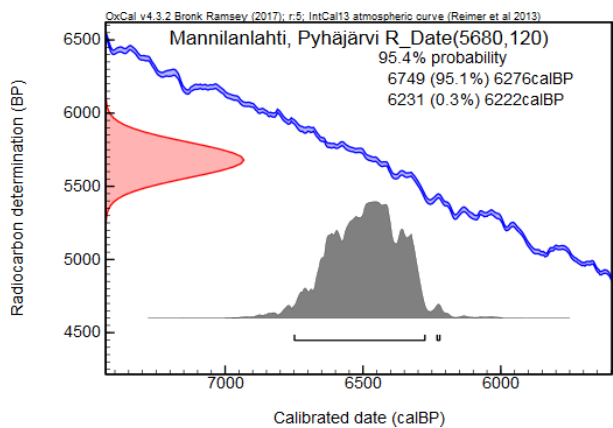
Figure 3. The calibration curve and the error distribution from Ox- Cal program (Bronk Ramsey,